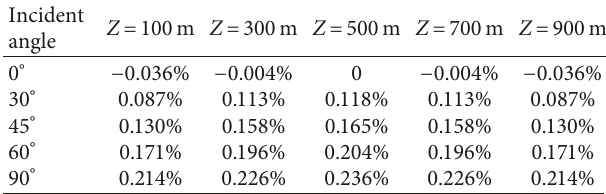
Figure 3: The simulated spatially varying seismic ground motions: (a) x Table 3: Lateral maximum diameter strain rate of tunnel under uniform seismic motion.